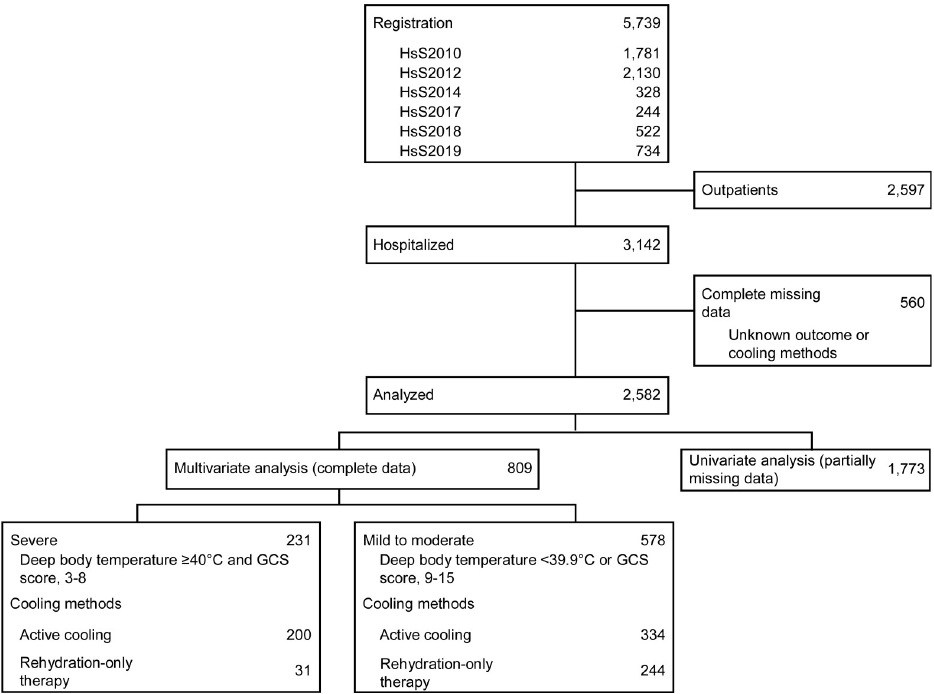
Fig 1. Patient selection process. Active cooling includes exclusively external, exclusively internal, and combined cooling. Rehydration-only therapy refers to fluid replacement without active cooling. HsS: Heat stroke Study; GCS: Glasgow Coma